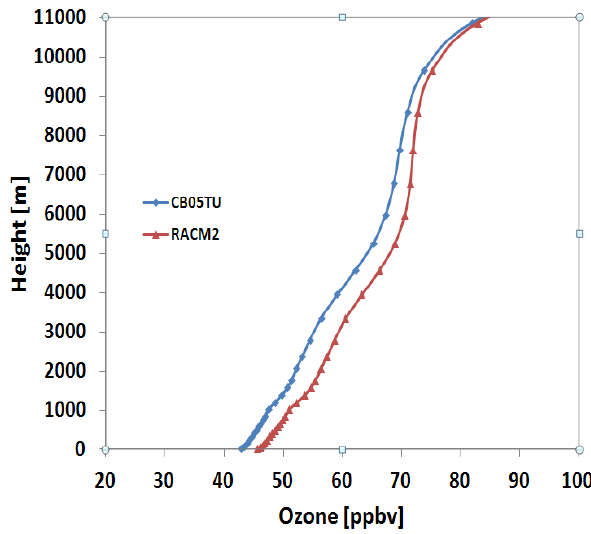
Fig. 8. Predicted vertical O 3 profile obtained with CB05TU and RACM2 at 18:00UTC on 13